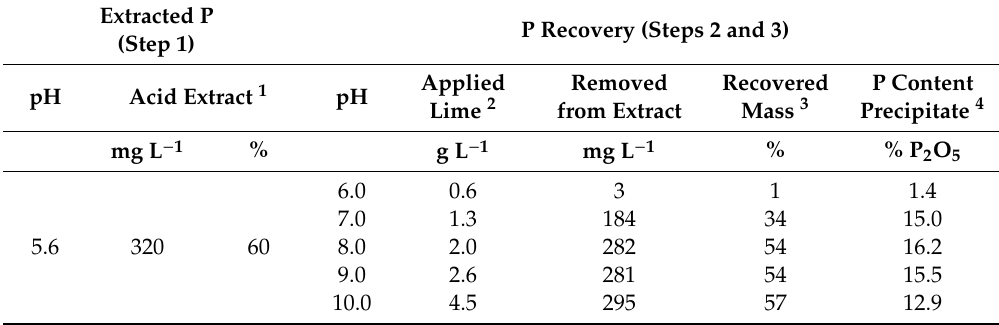
Table 3. Recovery of phosphorus dairy manure slurry using the Quick Wash process.